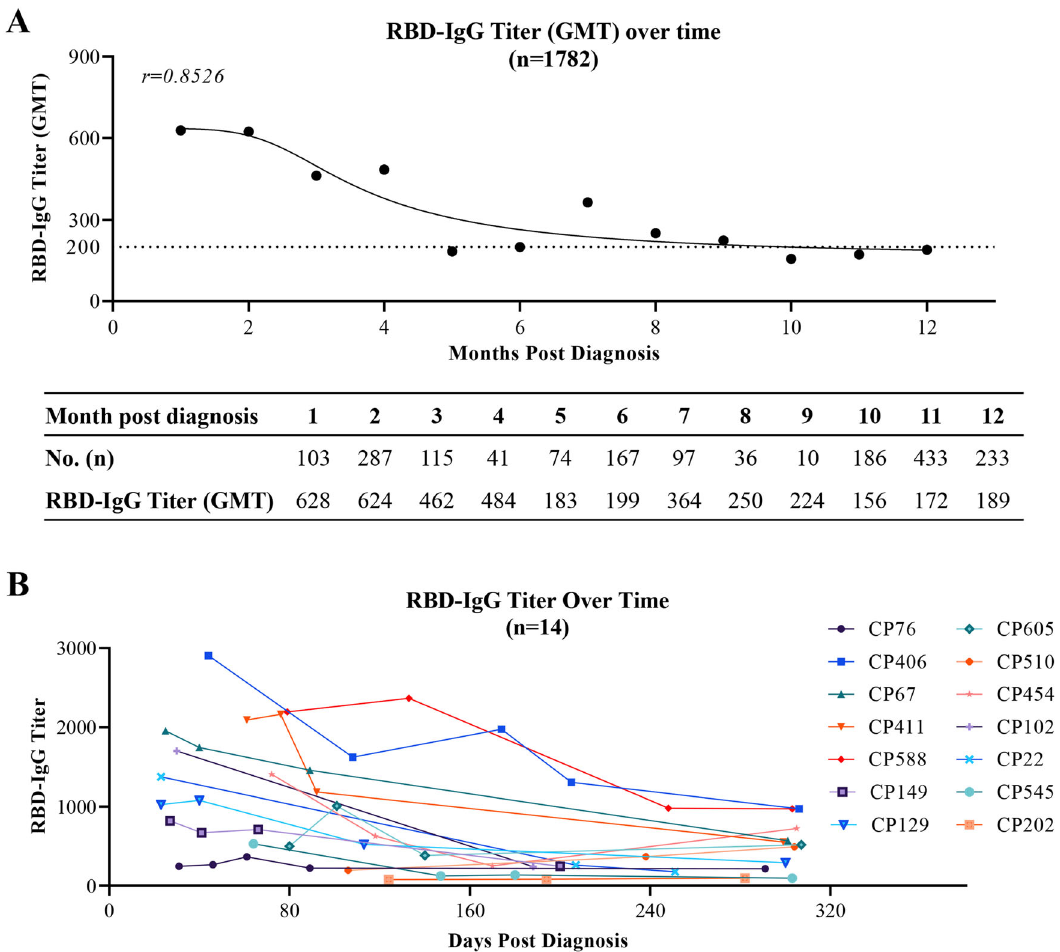
Fig. 2 Kinetics of SARS-CoV-2 RBD-IgG responses. A RBD-IgG kinetics curve of 1,782 plasma samples within 12 months. Monthly titer represents the GMT titer of all plasma samples collected in each individual month. GMT: Geometric mean titer. The value of RBD-IgG titer that was lower than the range (<1:10) was set to 1 for GMT calculation. B The RBD-IgG titers change in 14 COVID-19 convalescent plasma donors with multiple donations. CP76, CP406, CP67, CP411, CP588, CP149, CP129, CP605, CP510, CP454, CP102, CP22, CP545, CP202: the number of COVID-19 convalescent plasma donors. GMT, geometric mean